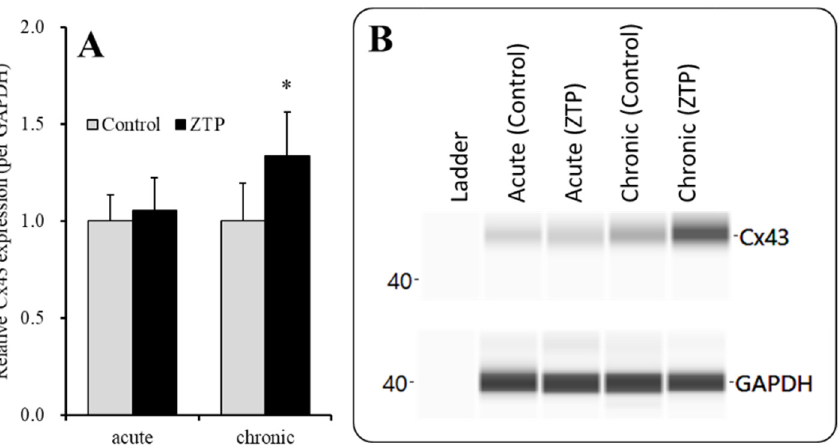
Figure 7. Effects of acute (120 min) administration of supratherapeutic concentration of ZTP (1000 nM) and chronic (14 days) administration of therapeutically relevant concentrations of ZTP (300 nM) on Cx43 protein expression in the plasma membrane fraction ( A ) and their pseudogel images, using capillary immunoblotting ( B ). Ordinate: mean ± SD (n = 6) of the relative protein level of Cx43 (per GAPDH). Effects of ZTP on Cx43 expression in the plasma membrane fraction of the primary cultured astrocytes were analysed by student T-test (* p < 0.05 vs. control: ZTP free).